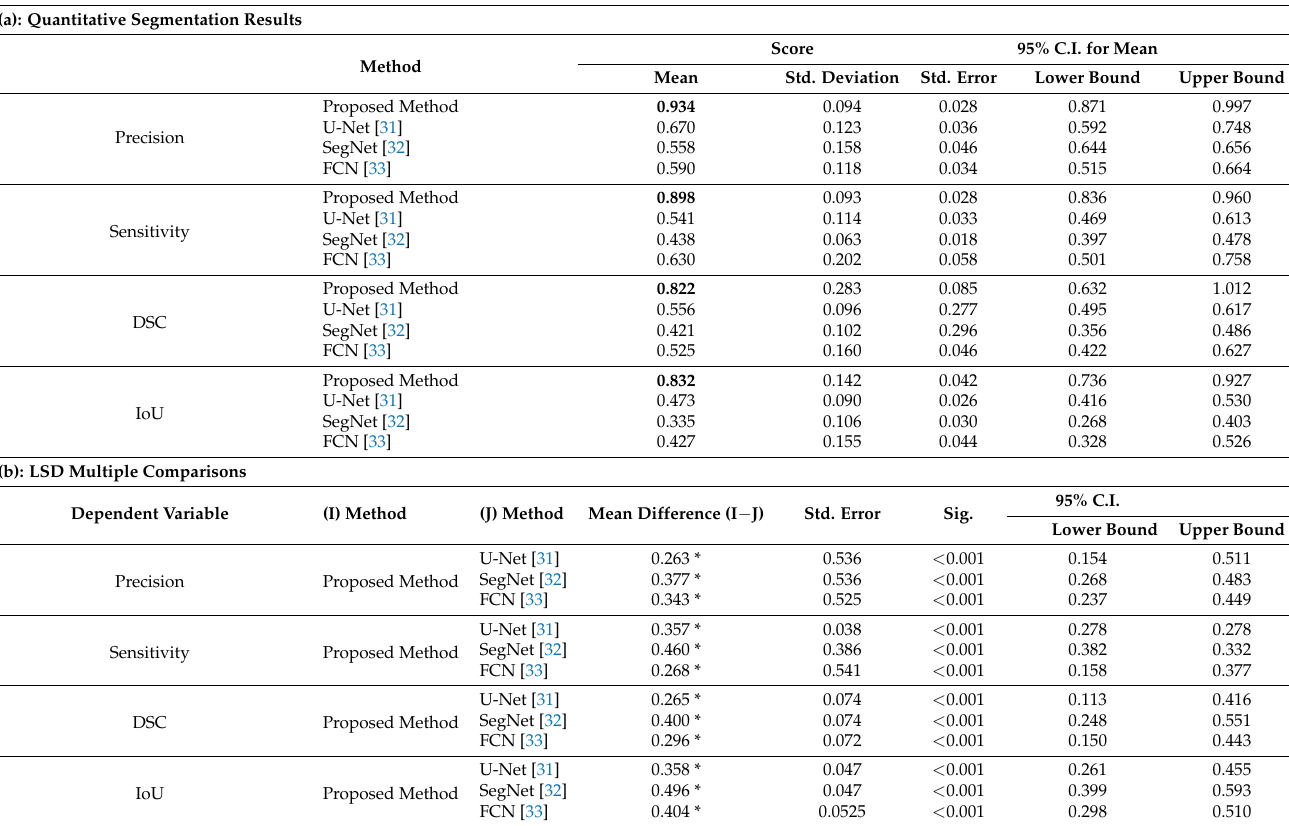
Table 2. The first experiment: quantitative evaluation and statistical analysis of the proposed method and the baseline methods in metastatic lesions segmentation on EBUS-TBNA